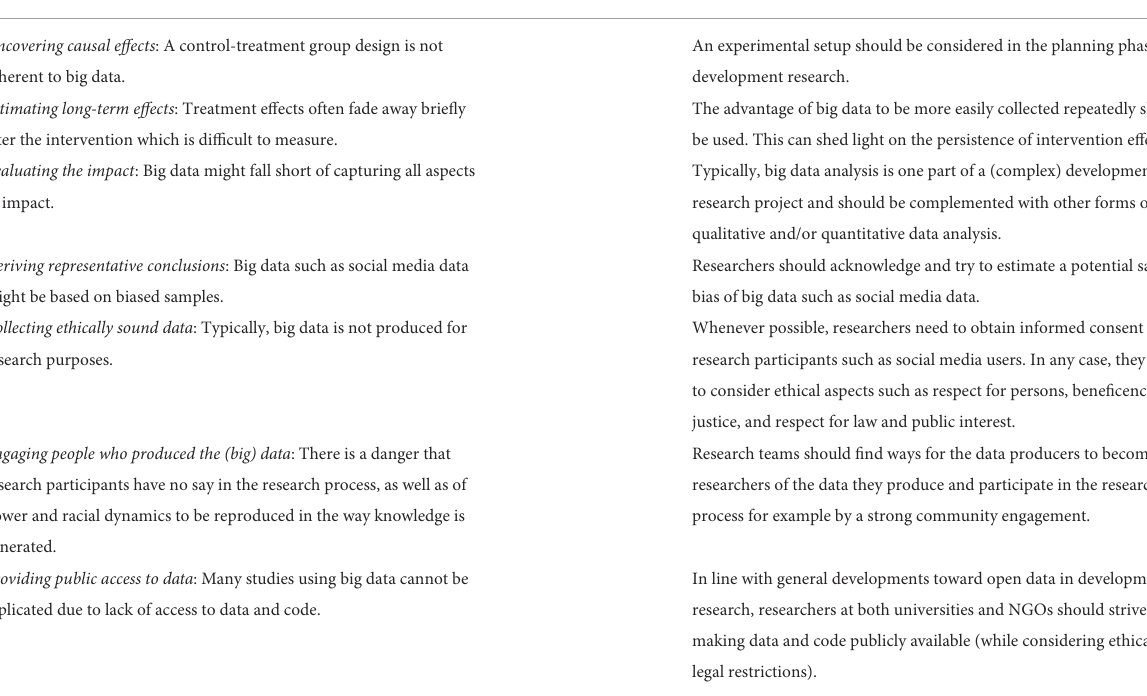
TABLE 6 Issues/challenges of big data analysis in the context of development sociology and recommendations. Issues/challenges